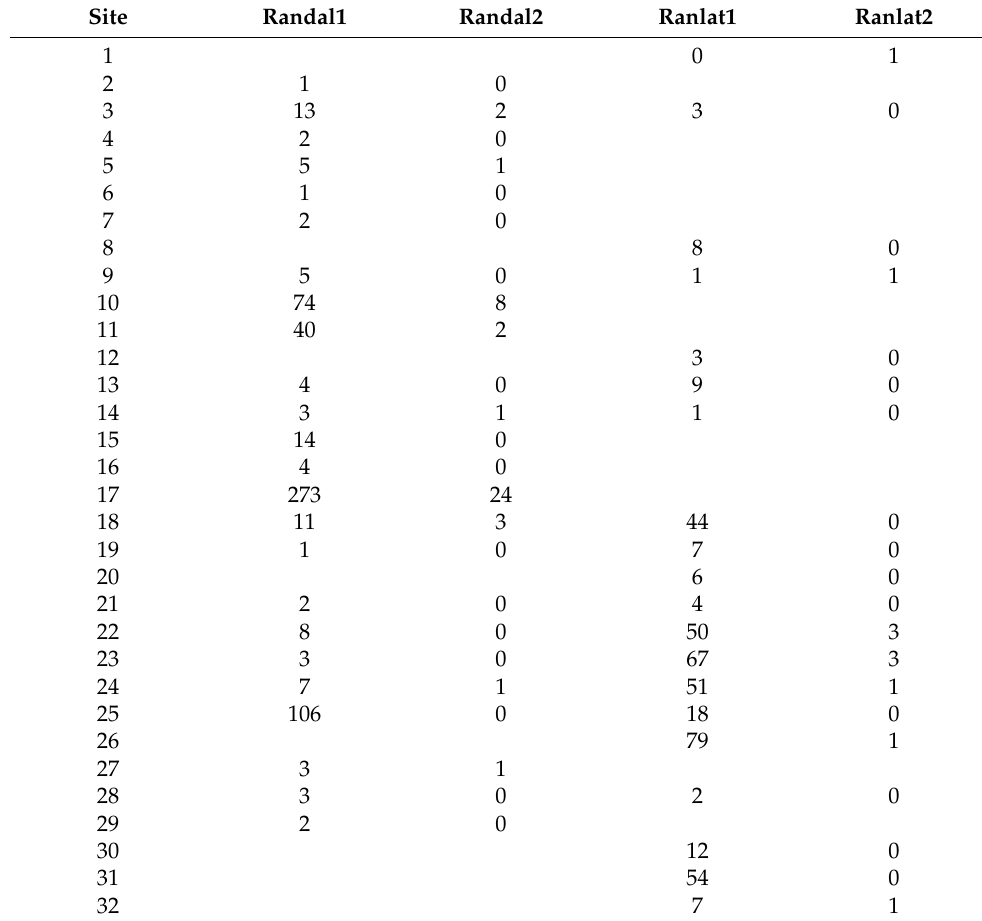
Table A1. Dataset used for the analyses of dependent double-observer counts of brown frog clutches. “Randal” and “Ranlat” indicate the counts for Rana dalmatina and Rana latastei for the first and second observers. Empty cells indicate sites with no counts of the target